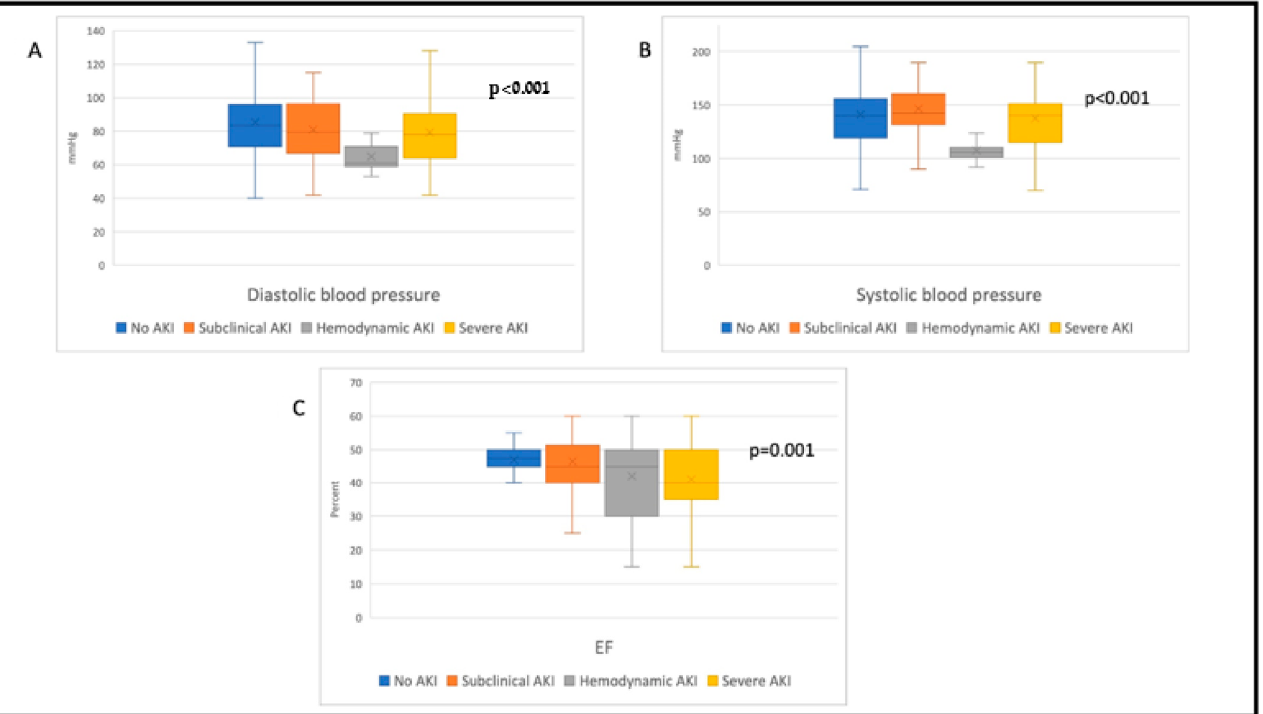
Figure 1. Hemodynamic results by group—( A ) diastolic blood pressure, ( B ) systolic blood pressure, ( C ) ejection fraction. In all tables, boxplot represents 1st and 3rd quarters, x represents the median, central line represents the mean, extreme brackets represent extreme min max values.